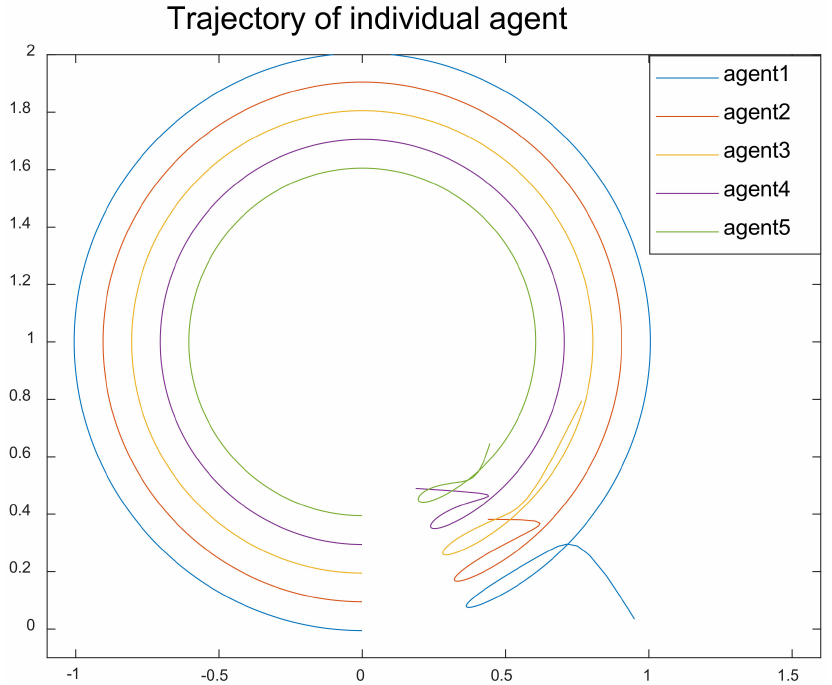
Figure 20. Trajectory of individual